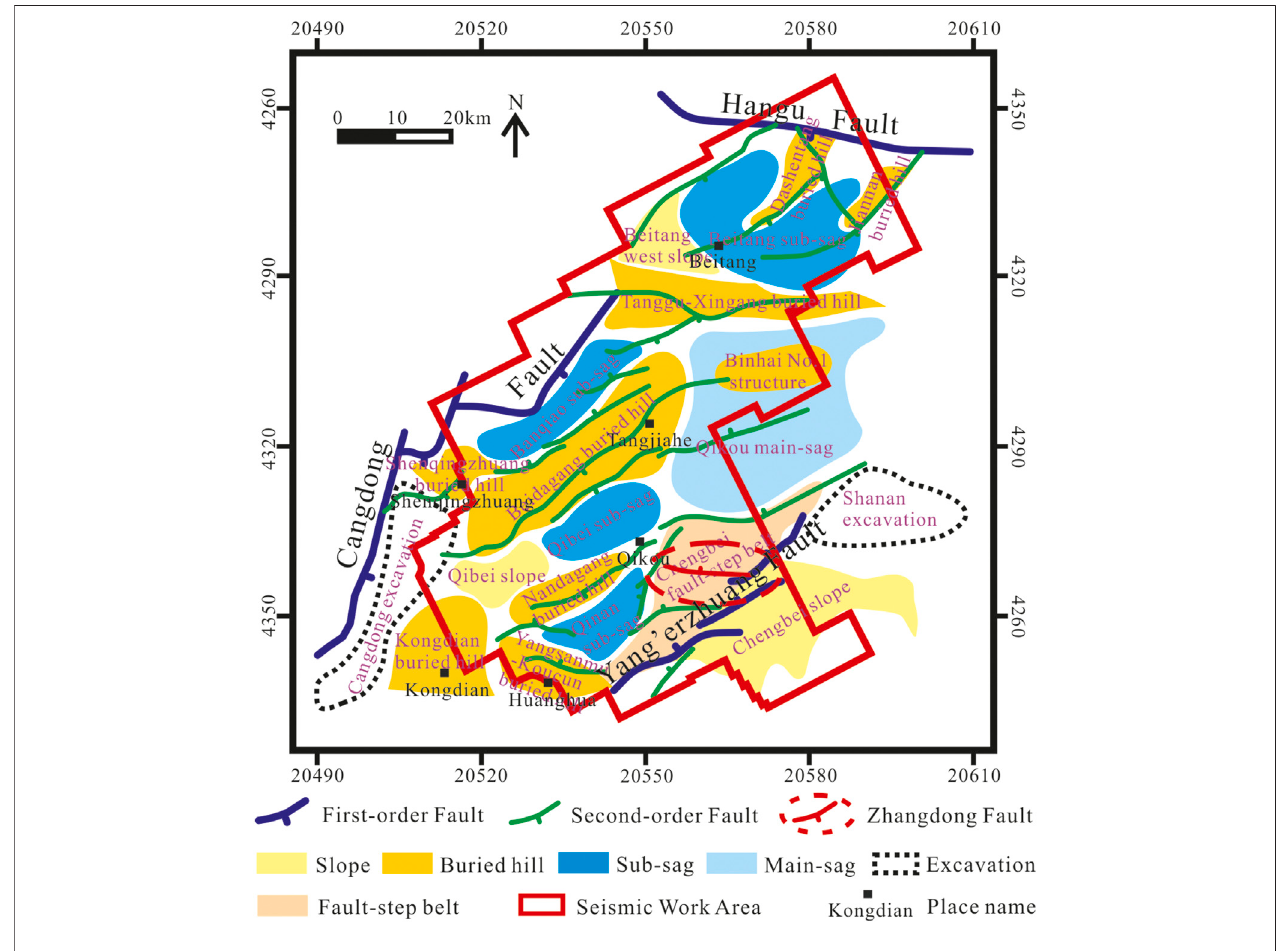
FIGURE 1 | Tectonic units and outline of the fault system in Qikou